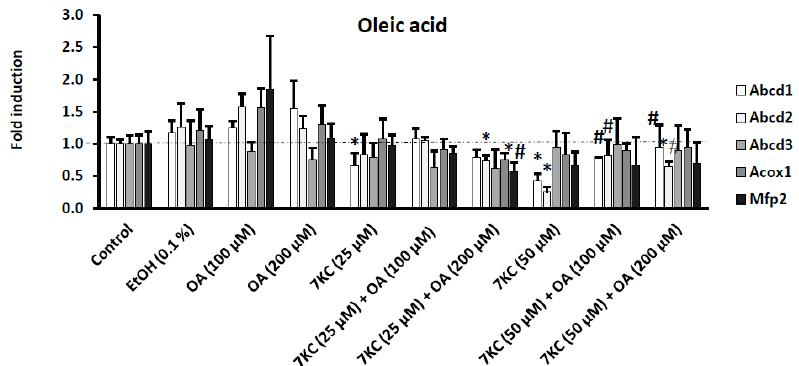
Figure 4. Effects of α -tocopherol, and γ -tocopherol, and oleic acid on 7-ketocholesterol-induced decreased transcription of Abcd1, Abcd2, Acox1 and Mfp2, specific proteins of peroxisomal β -oxidation, and on Abcd3 used as a marker of the peroxisomal mass. Murine microglial BV-2 cells were cultured for 24 h in the presence of 7KC (25–50 µM) without and with α -, and γ -tocopherol (400 µM), and oleic acid (OA: 100–200 µM). The mRNAs of the peroximal transporters (Abcd1, and Abcd2), and of the peroxisomal enzymes (Acox1, and Mfp2) as well as of Abcd3 (a marker of the peroxisomal mass) were quantified by RT-qPCR. To this end, 36B4 was used as the reference gene. No difference was observed between control and vehicle (EtOH 0.1%–1%)-treated cells. The EtOH values correspond to the highest EtOH concentrations added to the culture medium: 0.1% with OA, 0.5% with α -tocopherol, 1% with γ -tocopherol. Differences between control and 7KC-treated cells (* means significant differences by Mann–Whitney test; p ≤ 0.05). Differences between 7KC-treated cells and (7KC + ( α -tocopherol, γ -tocopherol, or oleic acid))-treated cells (# means significant differences by Mann–Whitney test; p ≤ 0.05). Data are mean ± SD of at least three independent experiments.